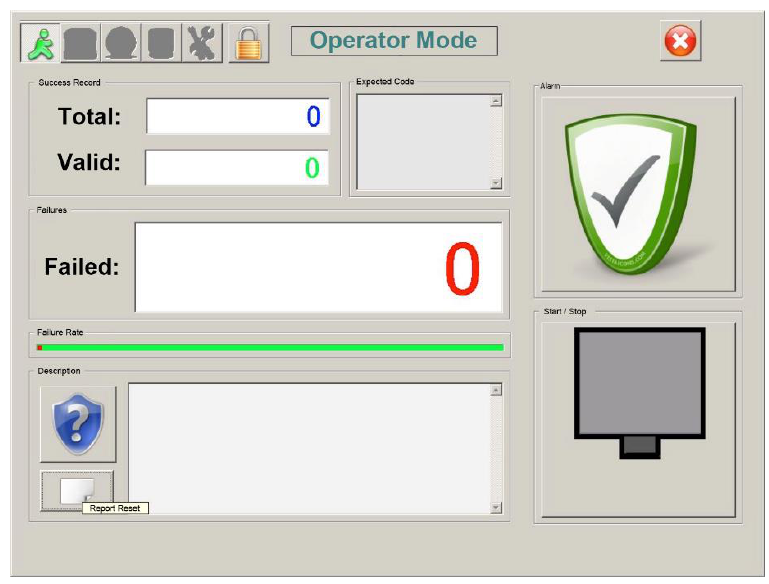
Figure 14. System output interface.